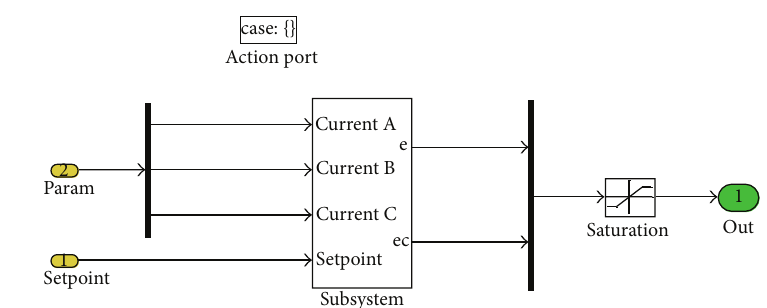
Figure 11: Internal details of three-phase current stabilizing controller